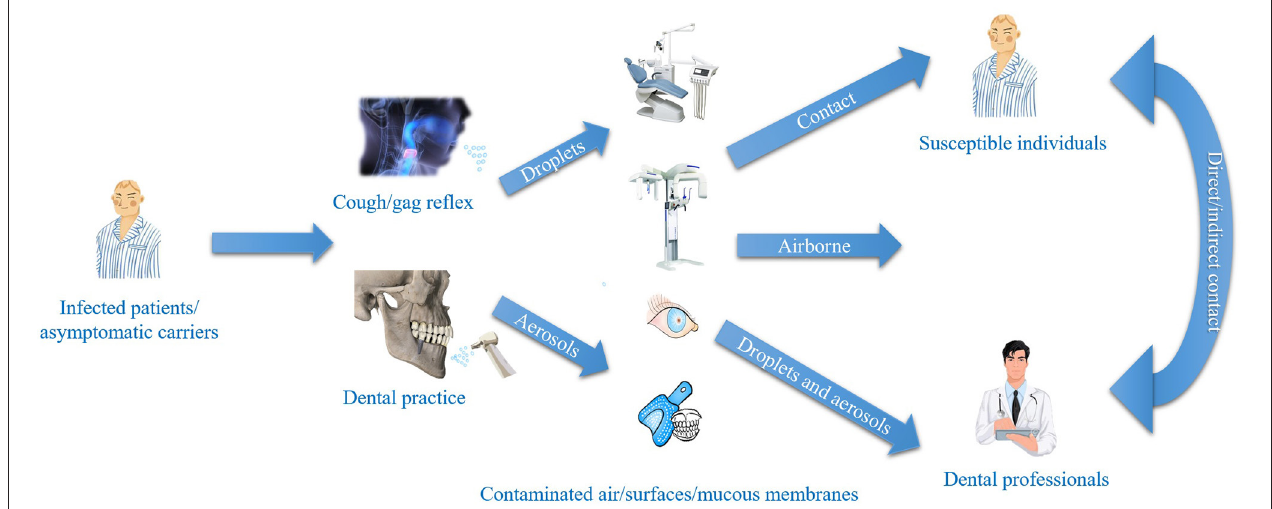
FIGURE 1 | The relationship between COVID-19 and